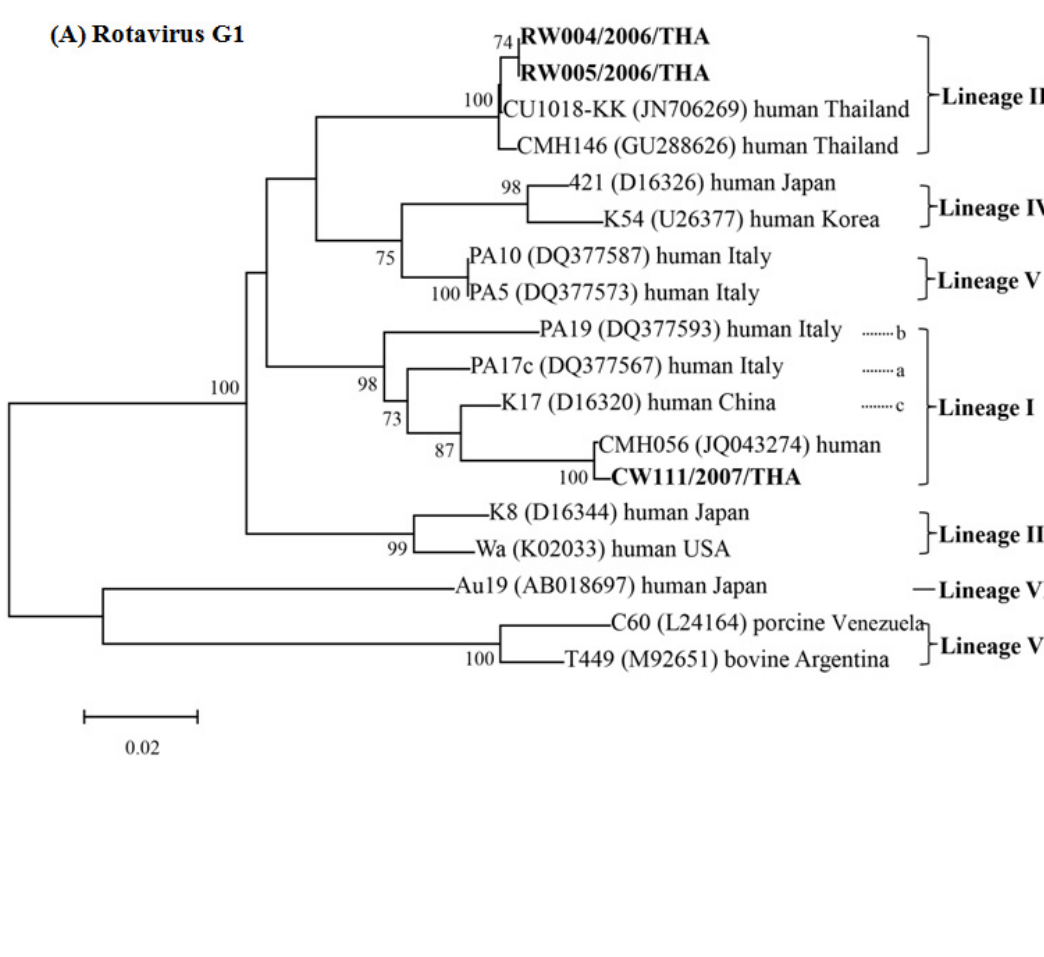
Figure 1. Phylogenetic trees of partial VP7 nucleotide sequences derived from rotavirus strains detected in this study and other reference strains from the GenBank